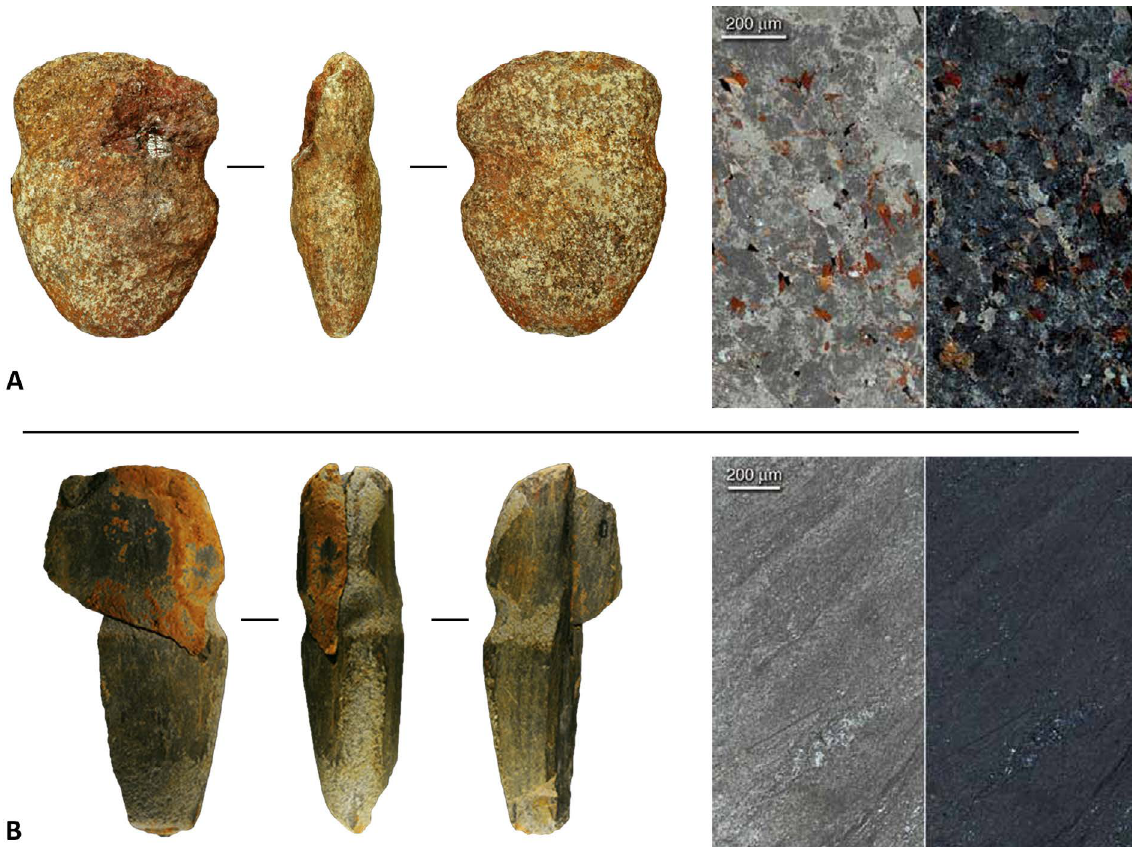
Figure 7. A. A worn high-grade metabasite hammer-axe; on the right can be seen the isotropic fabric of the rock in thin section. B. A broken glaucophane schist hammer-axe; its thin section shows a weakly schistose fabric (photos of the artefacts by F. Larocca, photos of thin sections from Acquafredda & Piccarreta in press